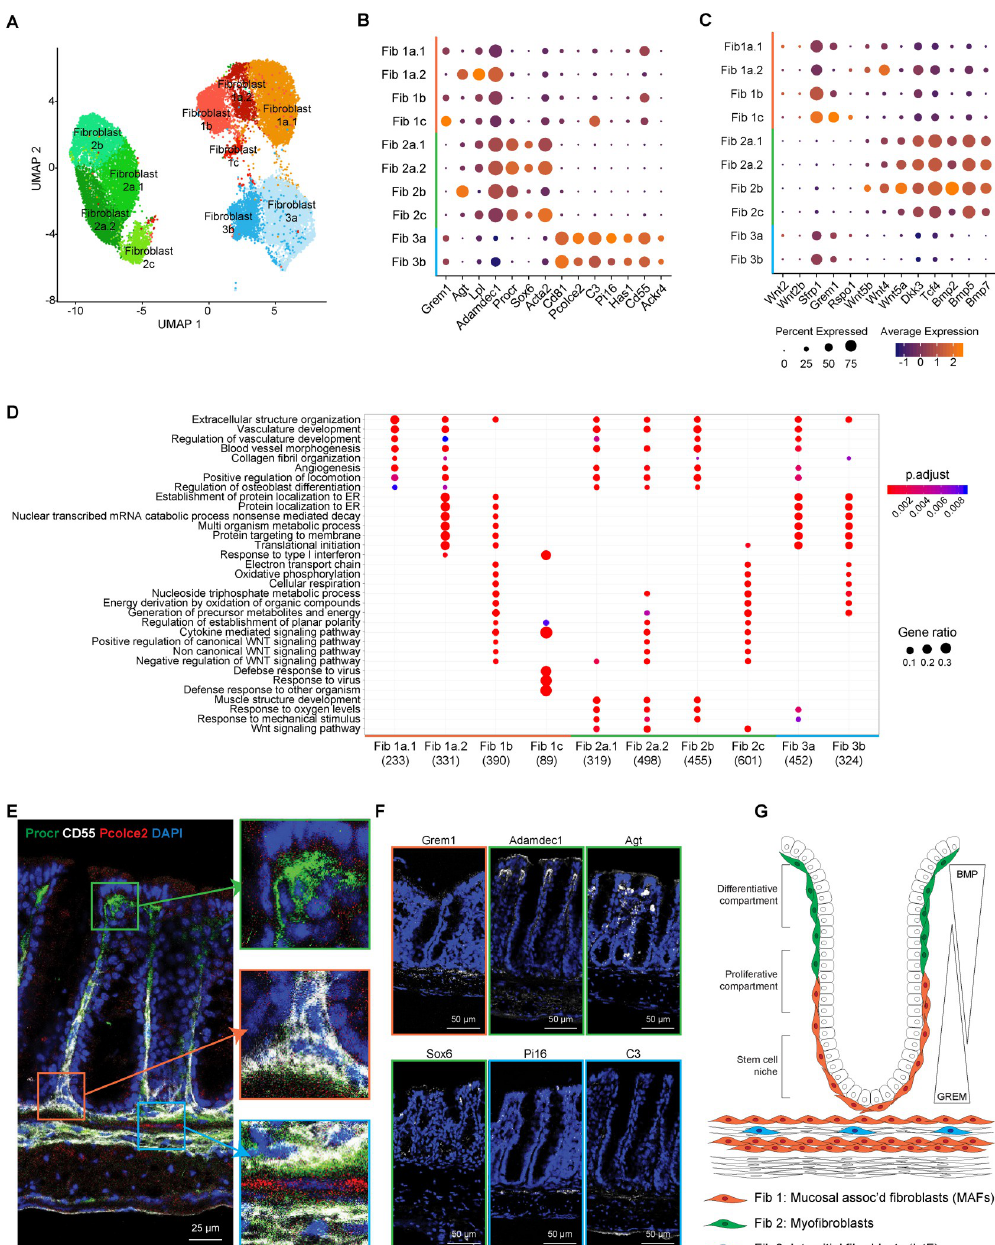
Fig 3. Single-cell profiling reveals functional and spatial heterogeneity of colonic fibroblasts. (A) Single-cell atlas of colon fibroblasts. UMAP of fibroblast (dots) profiles colored by cell type assignment. (B) Expression of canonical and newly characterized markers across fibroblast clusters. Color represents average expression of marker gene within clusters; diameter represents percentage expression of marker gene within cluster. (C) Expression of genes involved in maintaining colon crypt architecture. Color represents average expression of marker gene within clusters; diameter represents percentage expression of marker gene within cluster. (D) GO enrichment of DEGs for each fibroblast cluster at baseline (water-fed mice). (E) IF staining of 3 fibroblasts classes from water-fed mouse colon. Boxes zoom onto fibroblast subsets: green box- fibroblast class 1, orange box- fibroblast class 2, and blue box- fibroblast class 3. Pcolce2 (red), CD55 (white), Procr (green), DAPI (blue). Scale bar, 25 μ m. n = 3. (F) IF and FISH of various markers for fibroblast subsets. Fibroblast 1 (orange box): Grem1 (FISH). Fibroblast 2 (green box): Adamdec1 (IF), Agt (FISH), and Sox6 (IF). Fibroblast 3 (blue box): Pi16 (FISH), C3 (IF). Denoted stain (white), DAPI (blue). Scale bar, 50 μ m. n = 3. (G) Proposed distribution of 3 fibroblast classes within the colon. BMP, bone morphogenetic protein; DEG, differentially expressed gene; FISH, fluorescence in situ hybridization; GO, gene ontology; IF, immunofluorescence; IstF, interstitial fibroblast; MAF, mucosa-associated fibroblast; UMAP, uniform manifold approximation and projection.